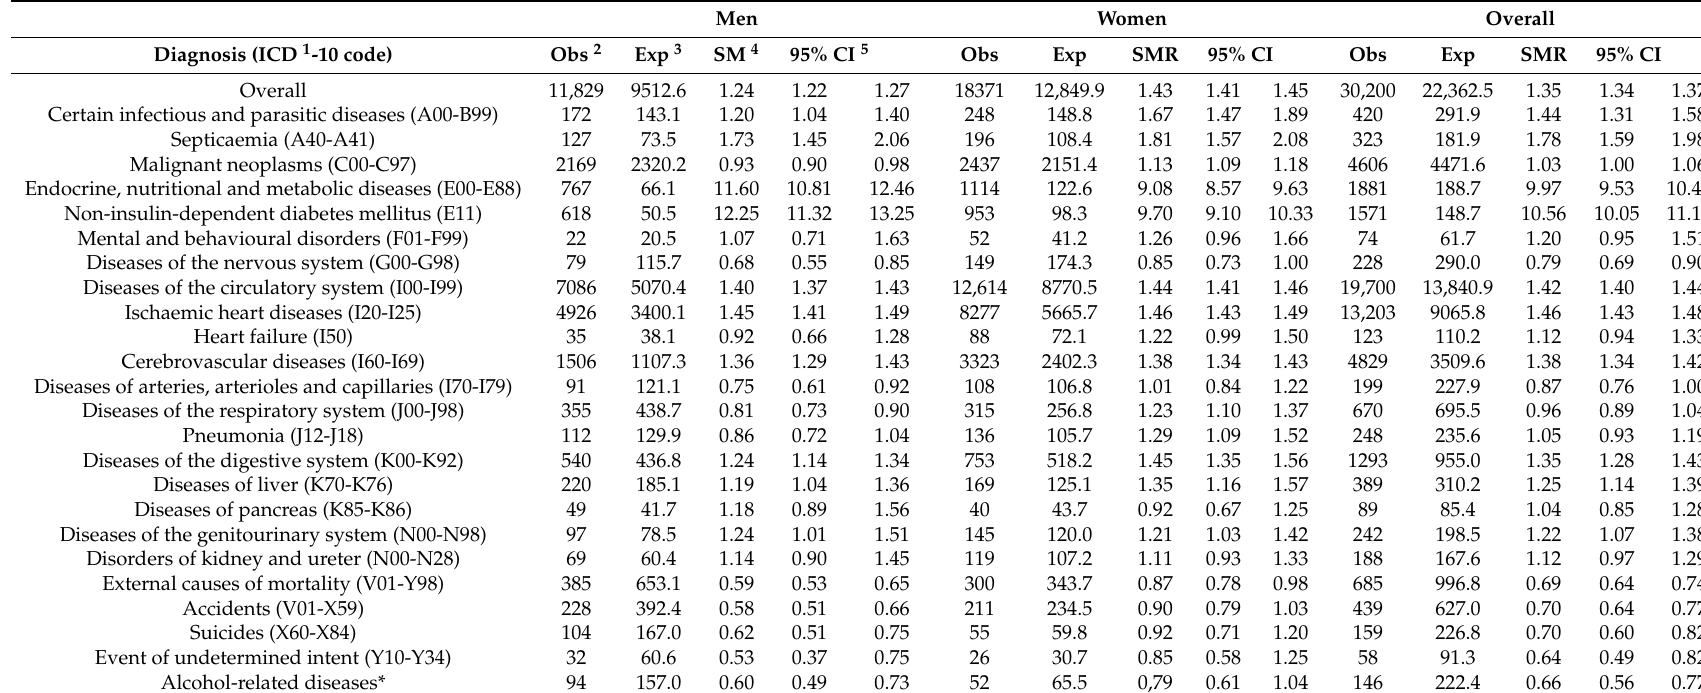
Table 3. Standardized mortality ratios for causes of death for men, women, and the overall